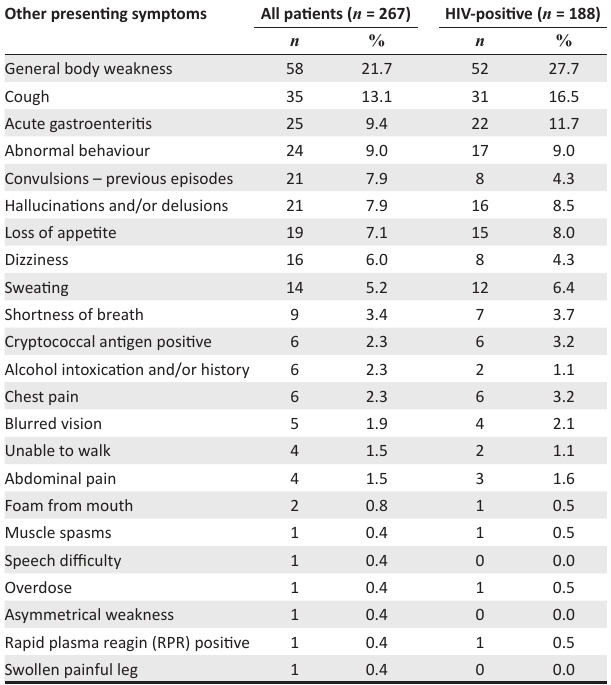
TABLE 2: Frequency of other symptoms in all patients and in patients who are HIV-positive. Other presenting symptoms All patients ( n =